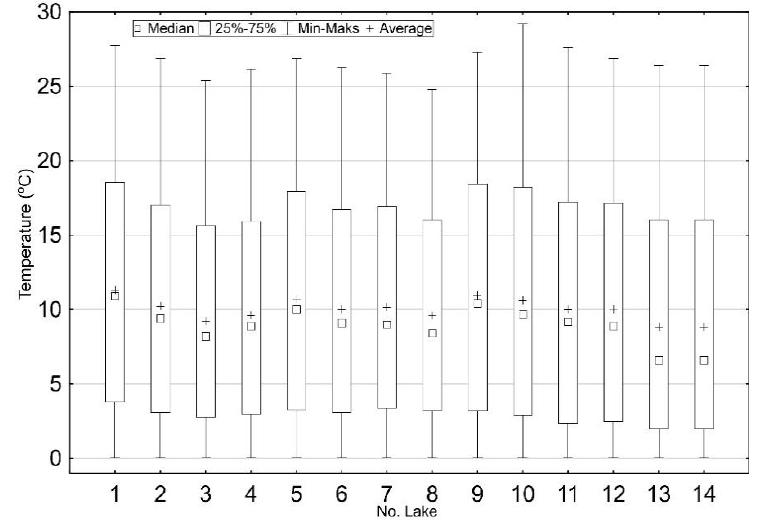
Figure 2. Daily lake water temperature distribution.